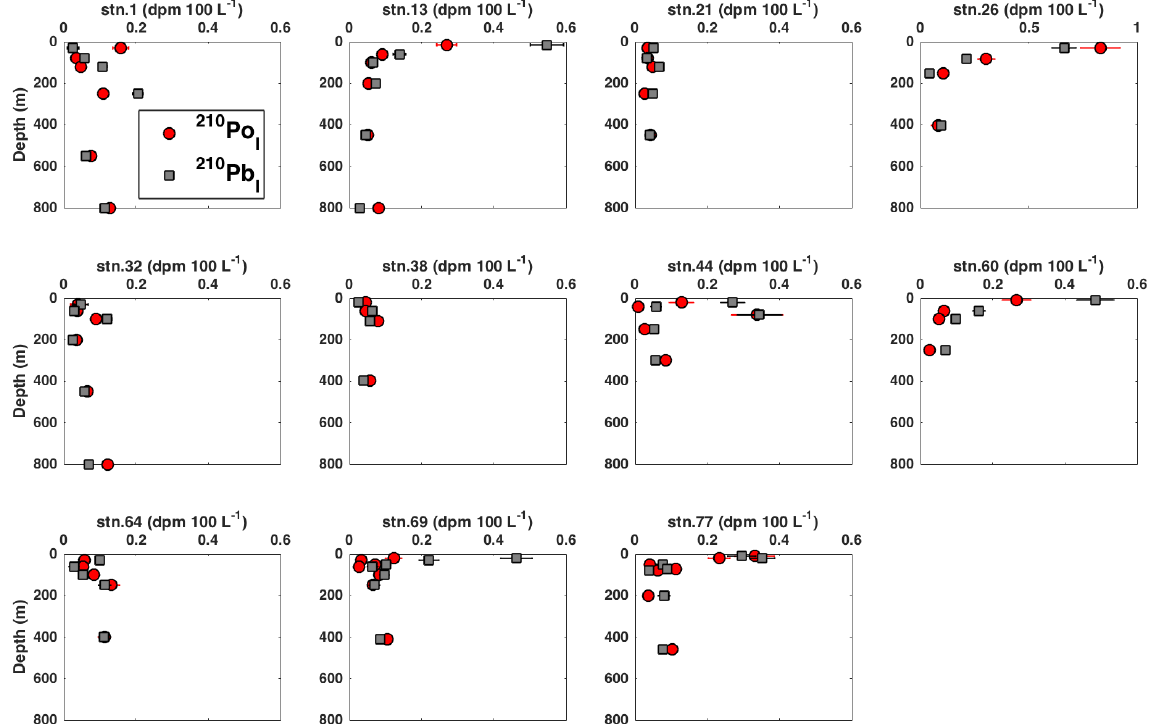
Figure 5. The vertical profiles of the particulate 210 Po and 210 Pb activity in the large size fraction ( > 53µm, 210 Po l , 210 Pb l ) in the top 800m. Note that the activity scale at station 26 differs from the scale in all other